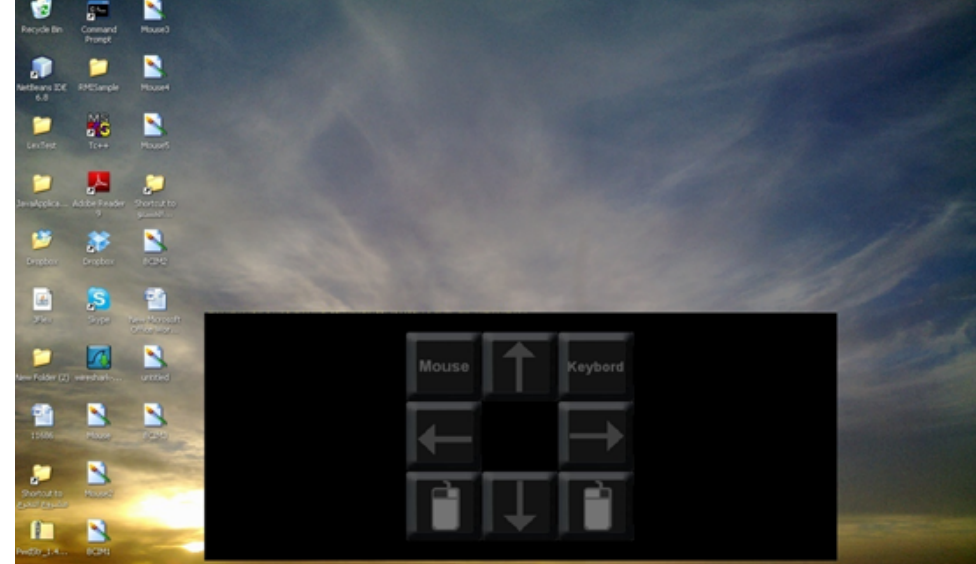
Figure 5. Controlling the mouse movement when no more divisions are